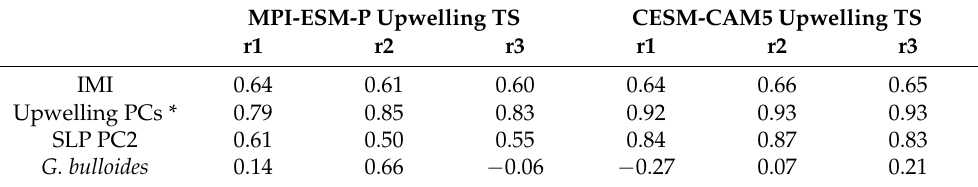
Table 1. Correlation coefficient between the coastal upwelling velocity in the western Arabian Sea and the Indian Monsoon Index (IMI), the upwelling PCs *, the SLP PC2, and the G. bulloides abundance for all the six simulations from the two models. All the correlation coefficients are calculated from the detrended time series and are significant at the 95% significance level except for the G. bulloides where only the second simulation of MPI-ESM-P presents the significant correlation. MPI-ESM-P Upwelling TS CESM-CAM5 Upwelling TS r1 r2 r3 r1